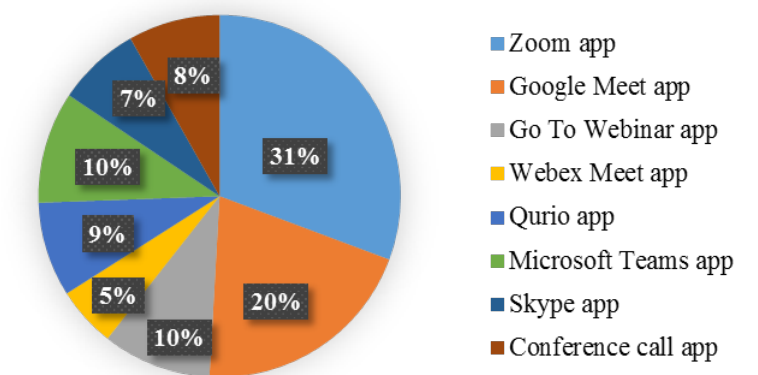
Figure - 16: Showing online learning app is most useful for the teaching and learning